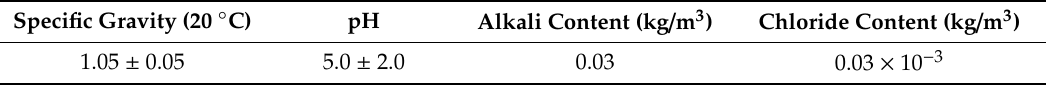
Table 7. Properties of superplasticizer.